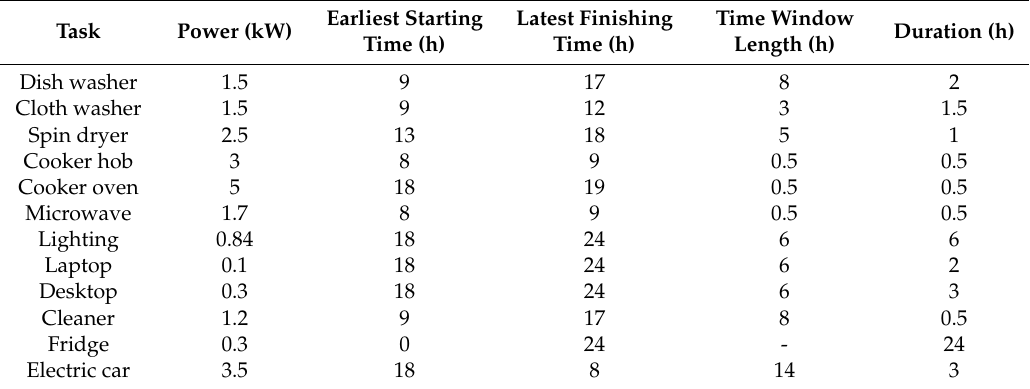
Table 1. Parameters of the